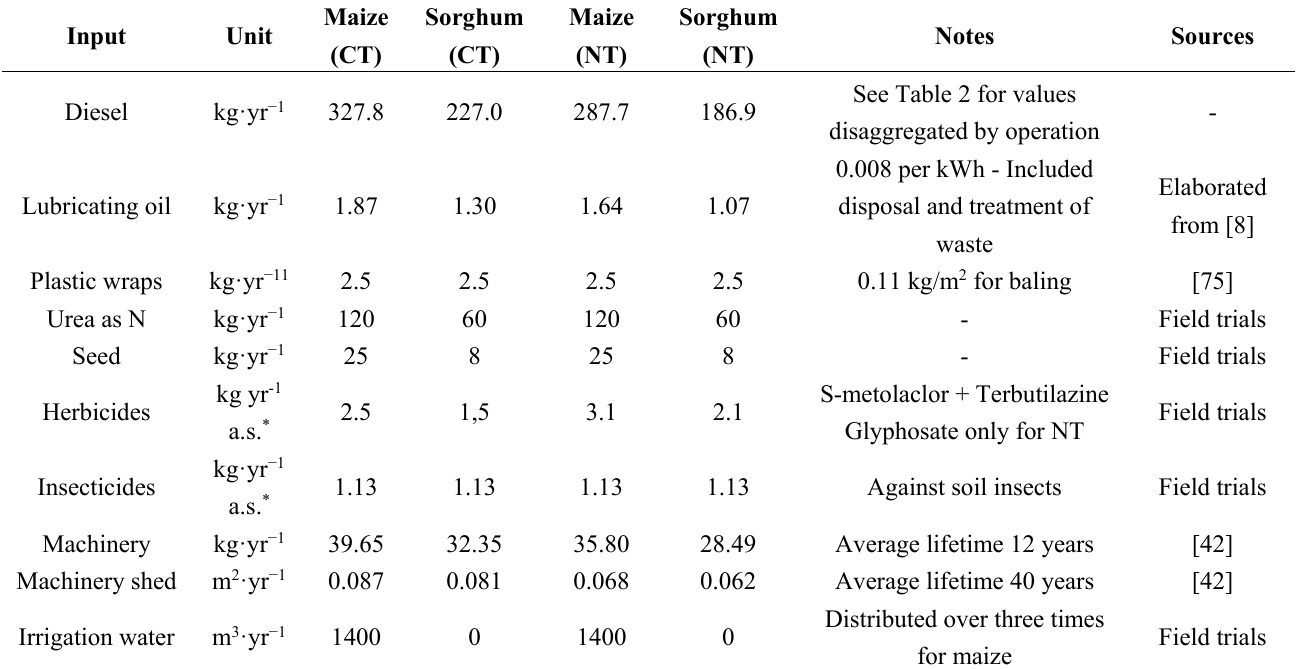
Table A1. Input data considered for the cultivation of 1 ha maize and sorghum silage under conventional tillage (CT) and no-tillage (NT).